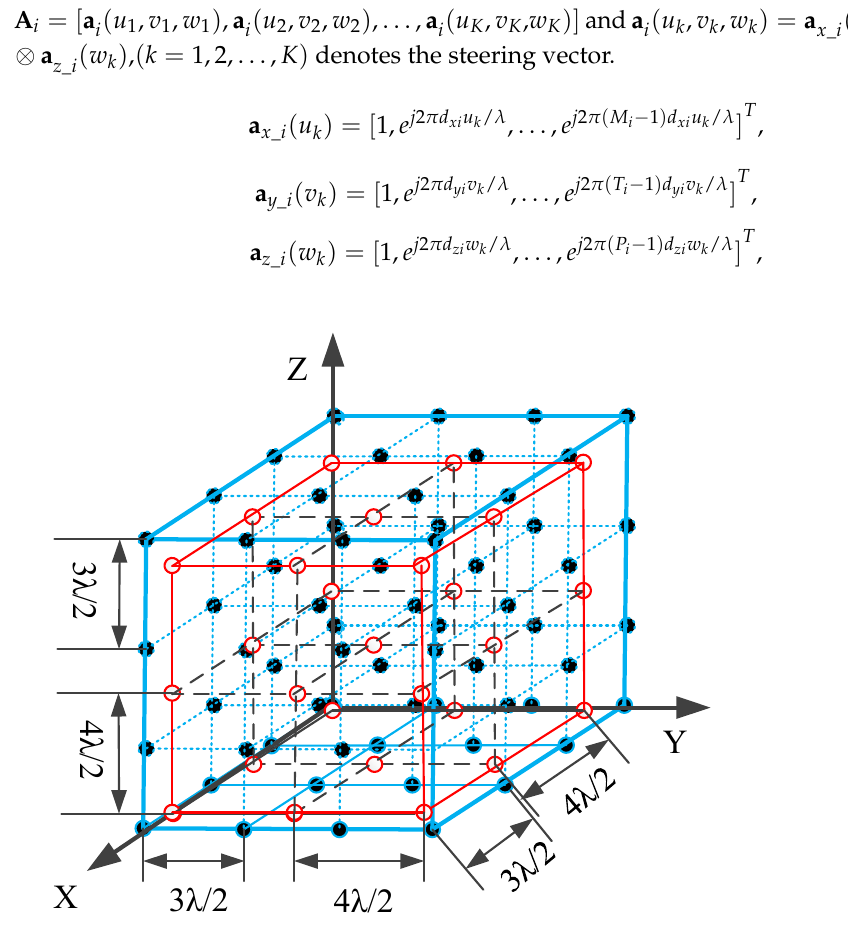
Figure 1. The structure of a CCA configuration ( M 1 = 4, T 1 = 4, P 1 = 4 and M 2 = 3, T 2 = 3, P 2 = 3